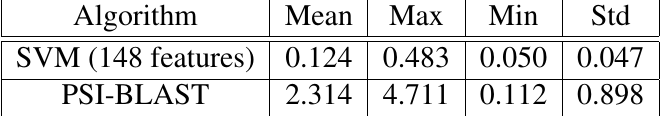
Table 3: Processing time (in seconds) to get a prediction for a single protein sequence: optimized SVM classifier versus PSI-BLAST. Mean, Max, Min and Std, are by this order the mean, the maximum, the minimum and the standard deviation for the times collected for 2002 test